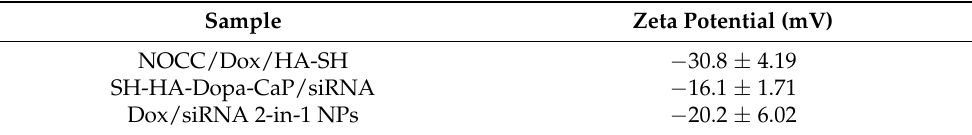
Table 1. Zeta potential of the